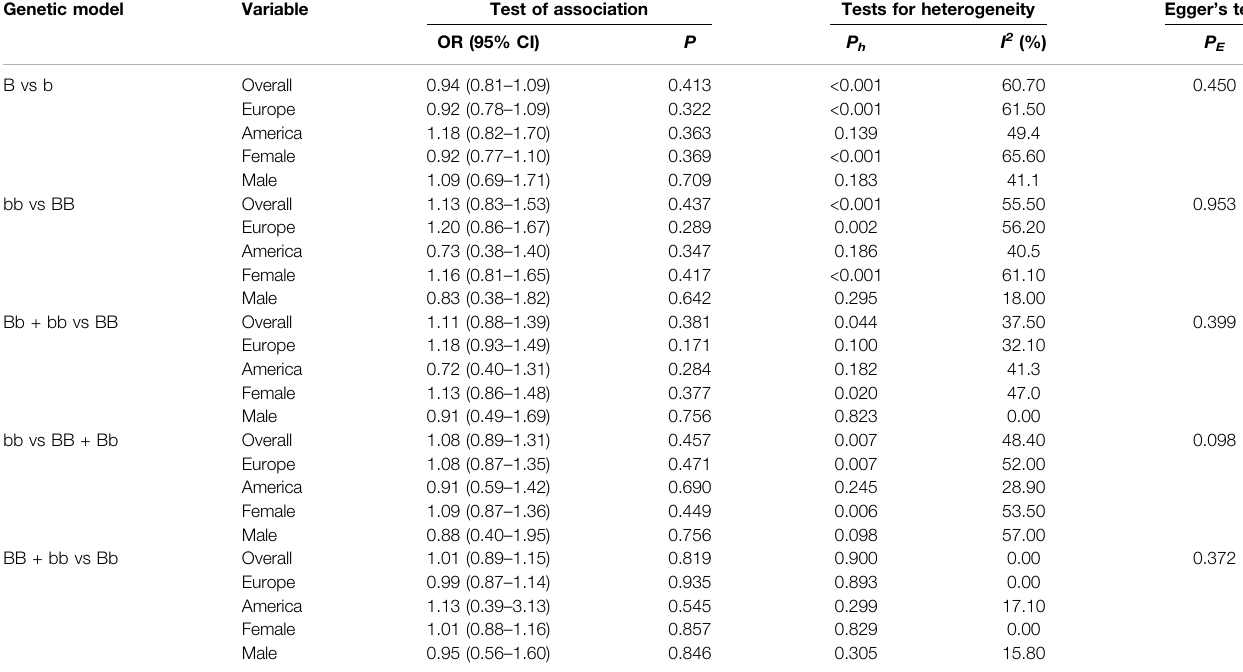
TABLE 7 | Pooled estimates of association of VDR BsmI polymorphism and the risk of osteoporotic fracture. Genetic model Variable